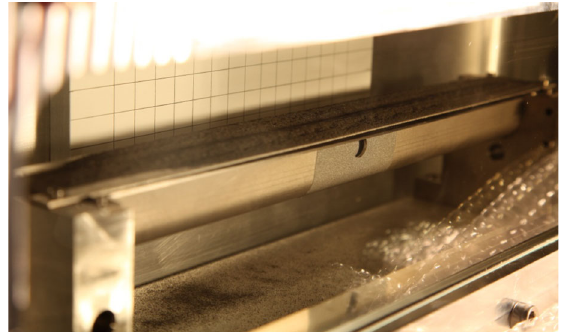
FIG. 12. Photo of powder trough after the experiment showing deep trench made in the powder sample and powder on the base of the containment